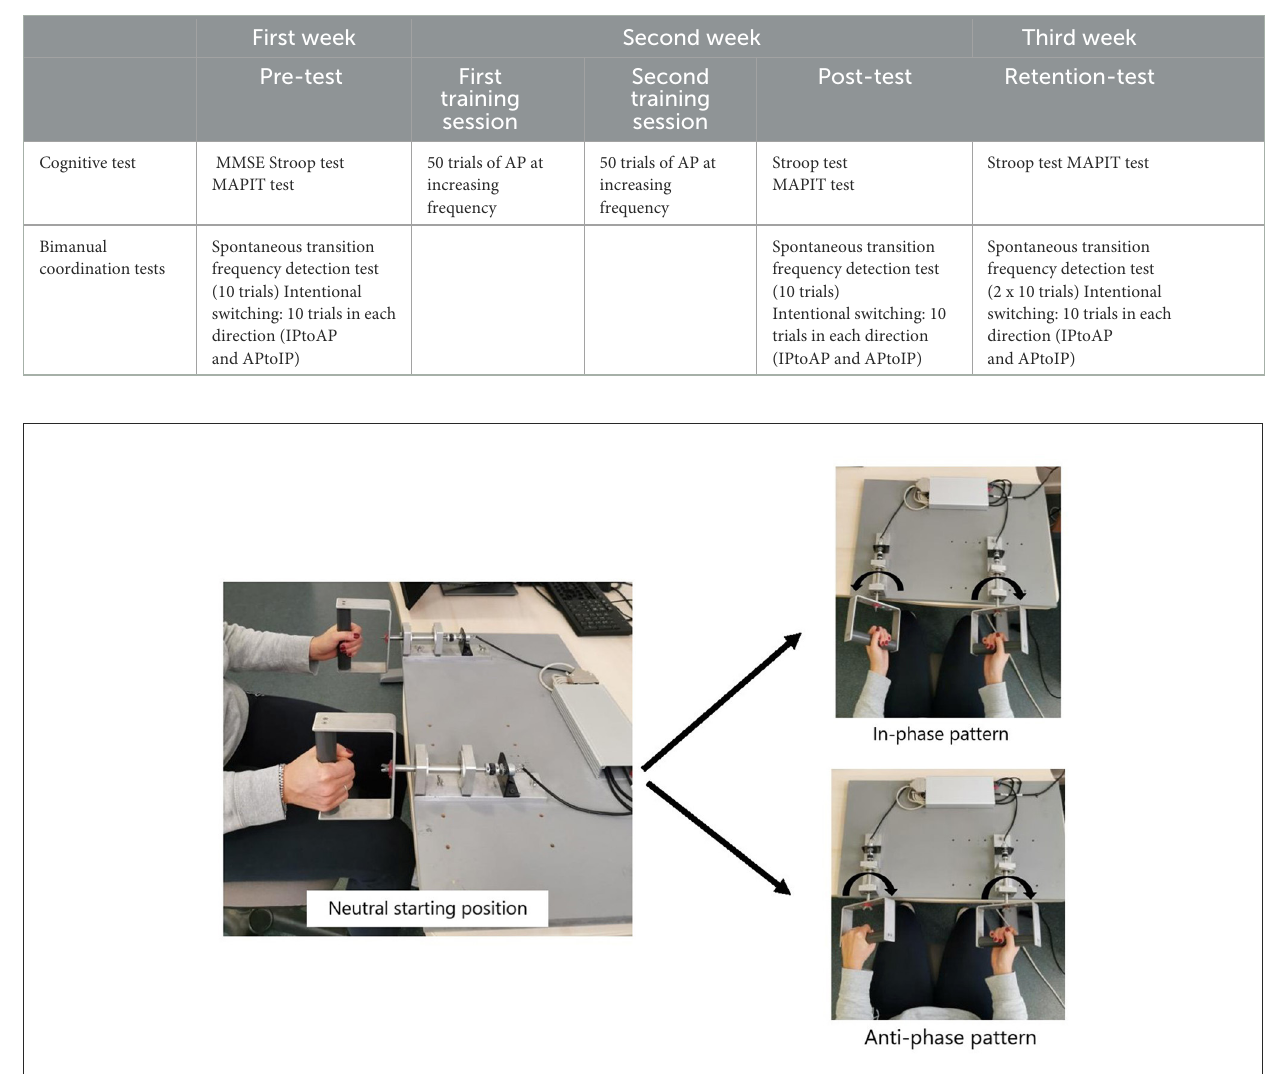
FIGURE1 Device used for the bimanual coordination task and visual representation of IP (In-phase) and AP (Anti-Phase) patterns.